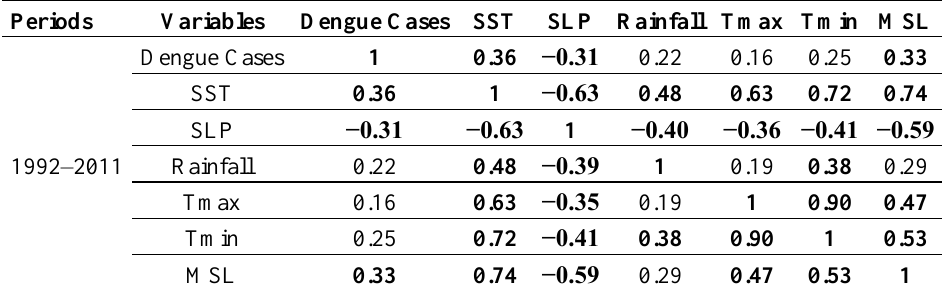
Table 4. Monthly correlation matrix Pearson. 1992–2011.